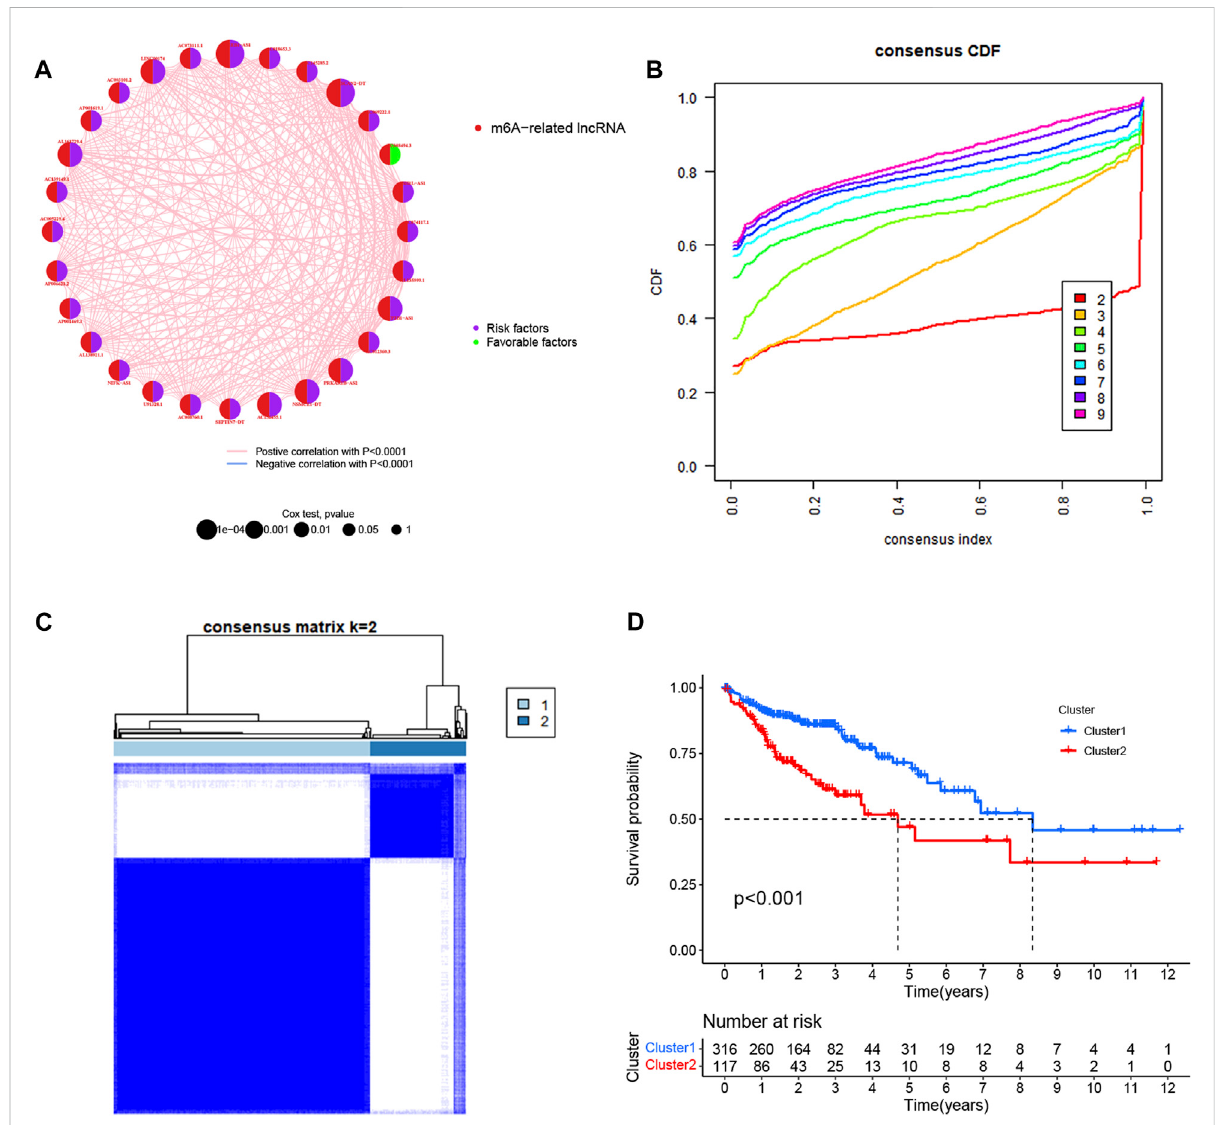
FIGURE 2 Identi fi cationofm6A-relatedprognosticlncRNAs. (A) Univariate coxregressionanalysis ofOSfor 28m6A-relatedprognosticlncRNAsinTCGA cohorts. (B) Consensus clustering cumulative distribution function (CDF) for k = 2 to 9. (C) Consensus clustering matrix for k = 2. (D) Kaplan – Meier OS curves for the two